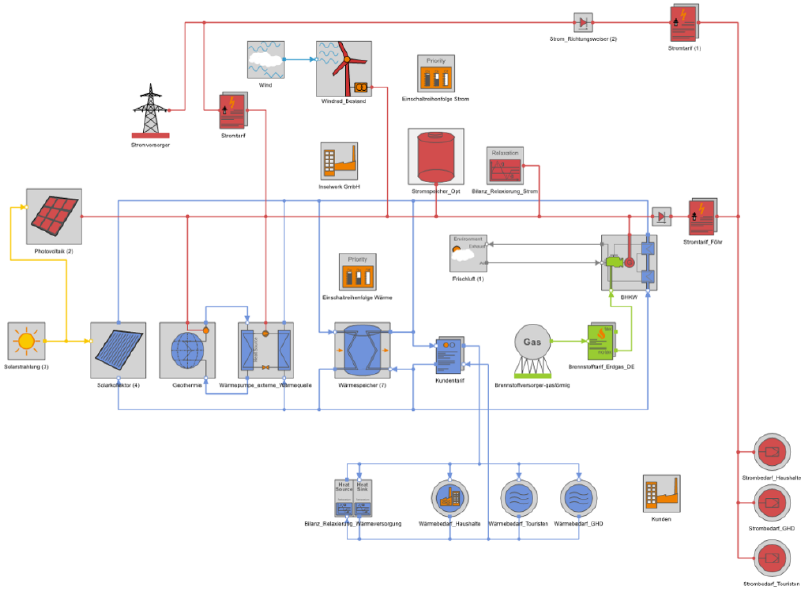
Figure 7. Model of the islands energy system’s target state involving RES